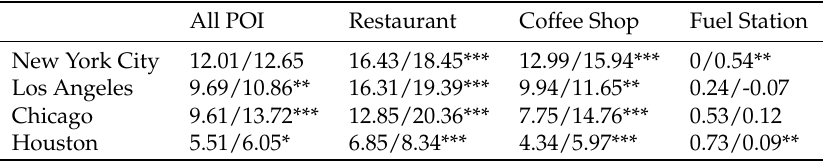
Table 6: Average minute decrease in visit duration between January 2020 and January 2021 split by low income and high income communities